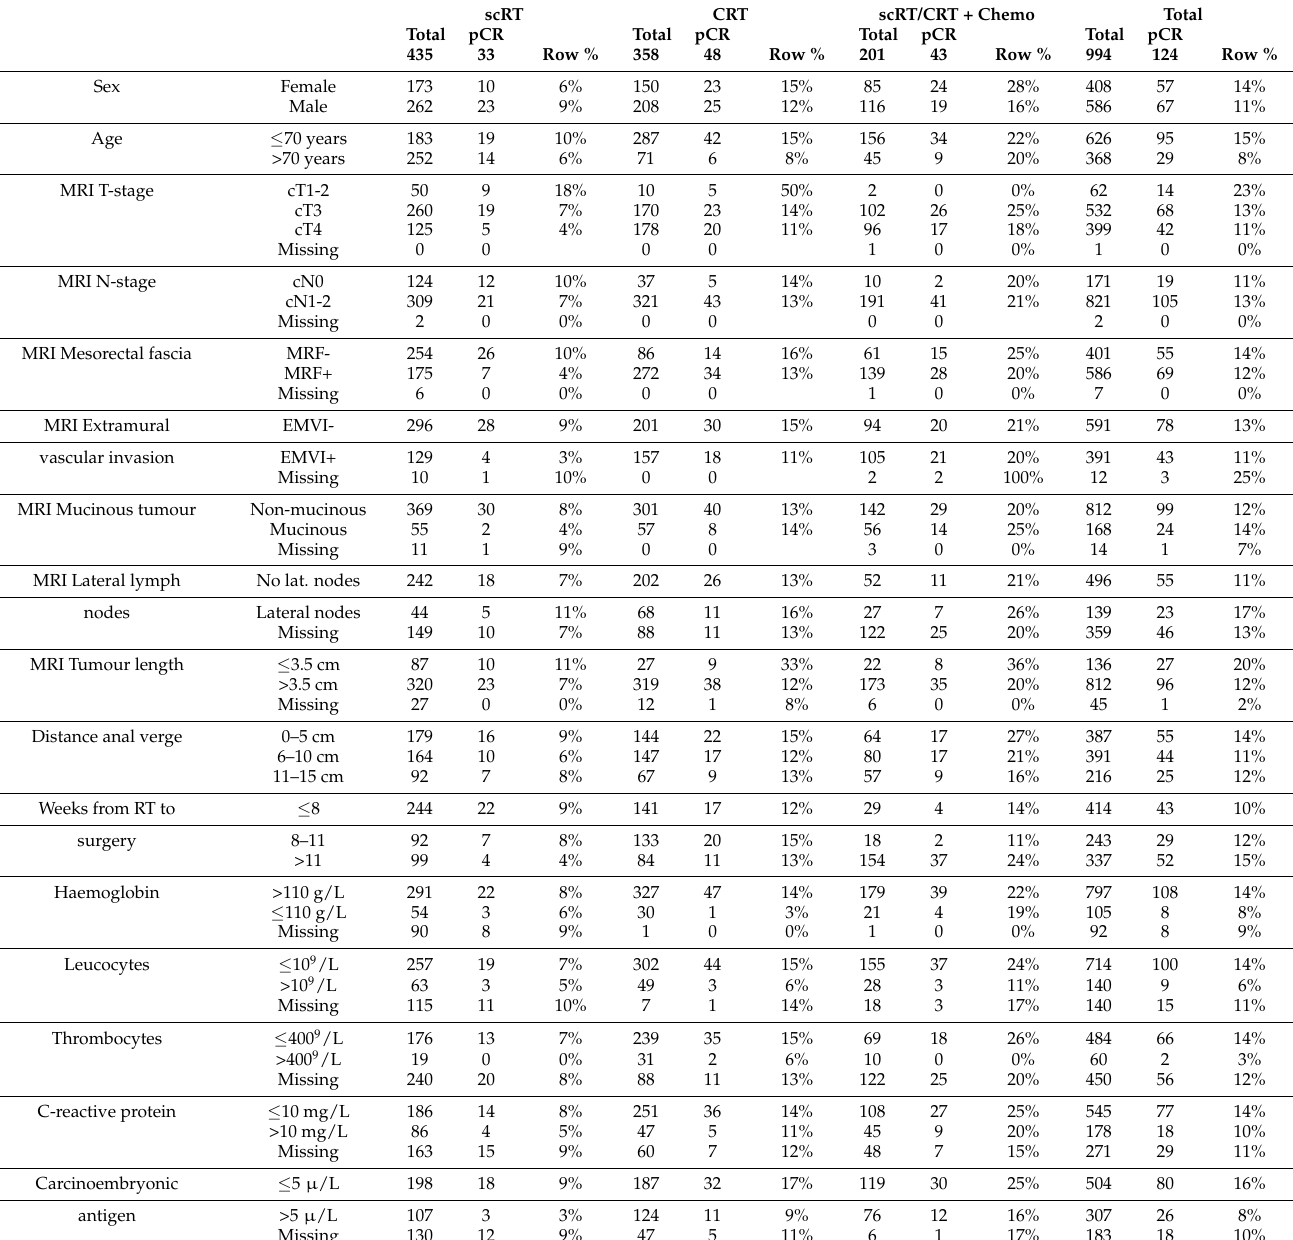
Data regarding the probability of reaching pCR according to treatment are shown in Table 3. Significant differences for all patients were noted for age, cT-stage, cN-stage, cMRF, cEMVI, mucinous tumour, and weeks from RT to surgery for treatment (exact p -values not shown). Differences in pCR rates for the scRT group were noted for cT-stage, cMRF, cEMVI, and CEA. For the CRT group, differences in pCR versus non-pCR were noted for cT-stage, tumour length, and elevated CEA. For the scRT/CRT + CTX arm, only sex was statistically significant in the pCR versus non-pCR comparison. Table 3. Observed frequencies of pCR according to major clinical parameters in the treatment